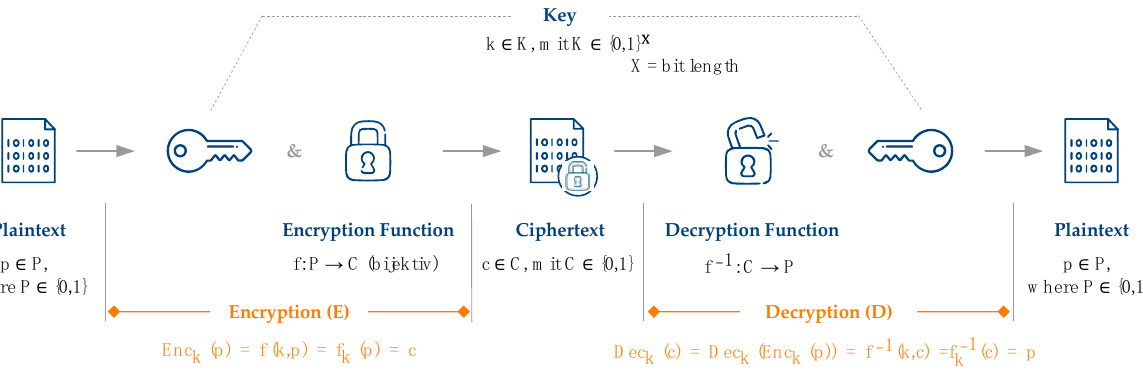
Figure 1. Basic encryption process based on the quintuple of cryptosystems.